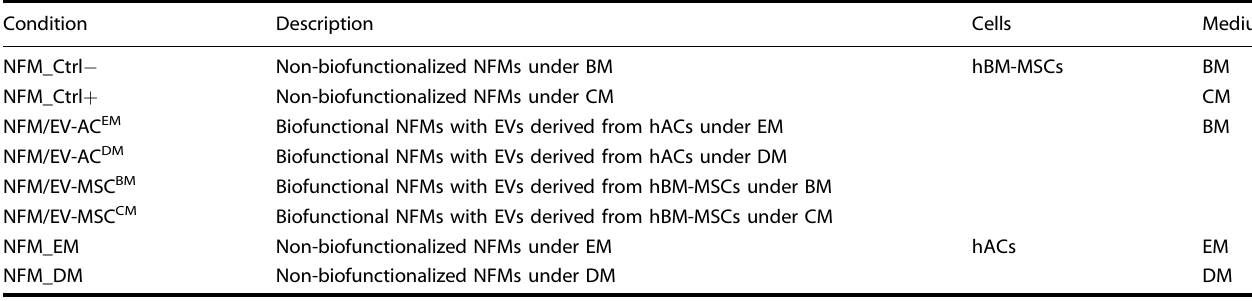
Table 1. Experimental conditions used in the cell biology